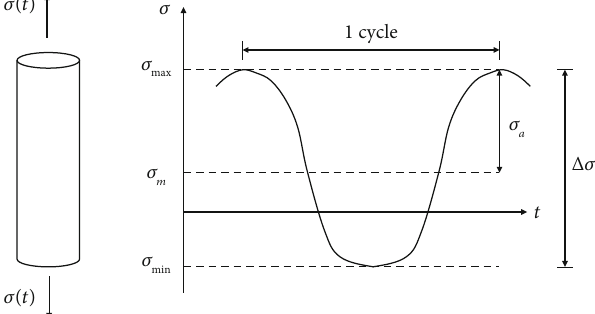
Figure 11: Illustration of the stress parameters for a cylindrical specimen under the time-varying axial stress σ ð t Þ